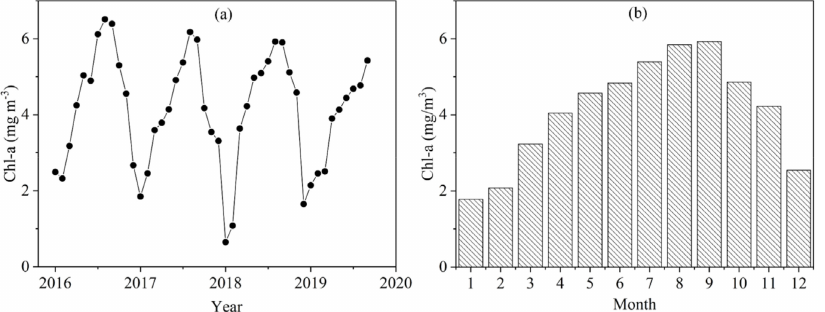
Figure 10. ( a ) Temporal variation in mean monthly chl-a concentration in study area from 2016 to 2019, and ( b ) the seasonal variation of multi-year average chl-a concentration.